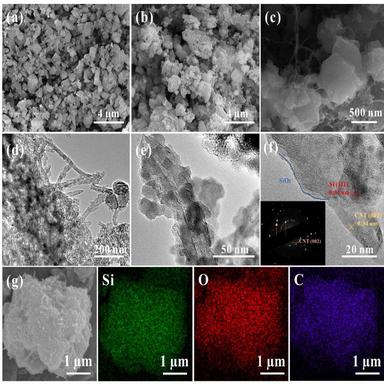
(a) SEM image of glass/CNTs; (b) and (c) SEM images of g-Si/CNTs composite; (d-f) TEM images and HR-TEM images of the g-Si/CNTs composite with the inset showing the corresponding selected-area electron diffraction pattern; (g) Elemental maps of the g-Si/CNTs composite.